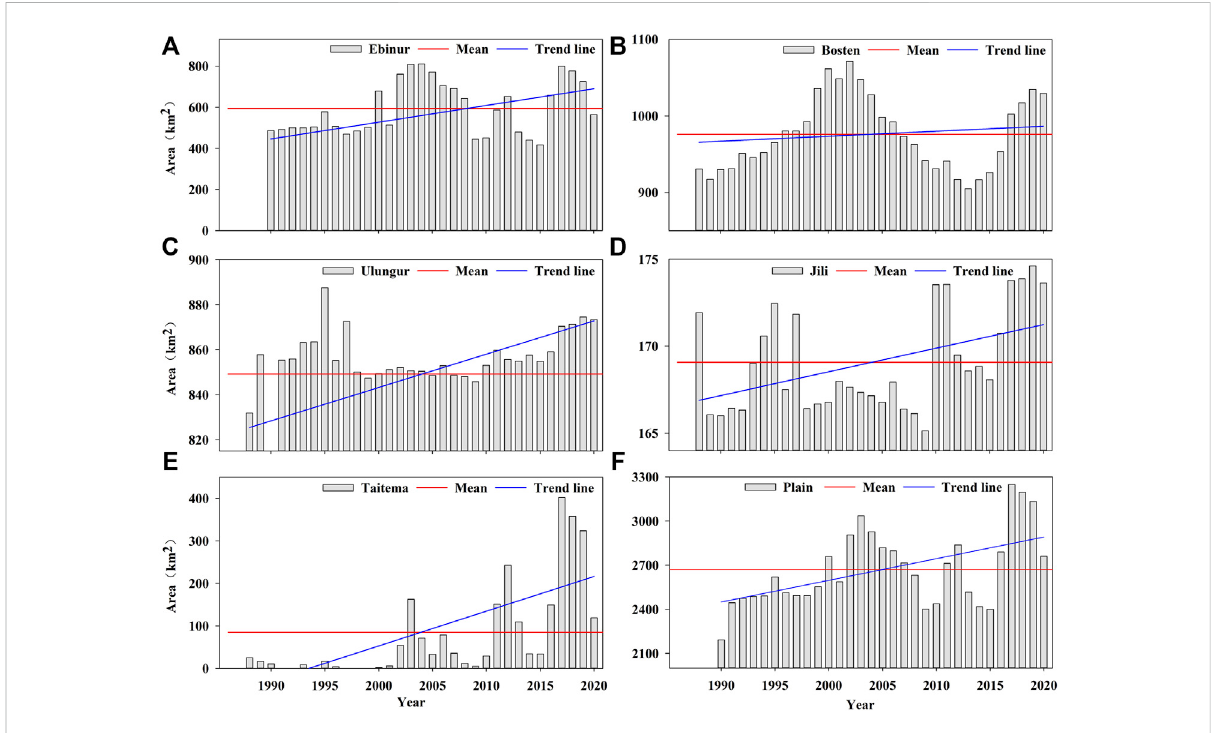
FIGURE 3 Area changes of typical plains lakes in Xinjiang from 1986 to 2020 (A) Lake Ebinure; (B) Lake Bosten; (C) Lake Ulungur; (D) Lake Jili; (E) Lake Taitema; (F) the plains